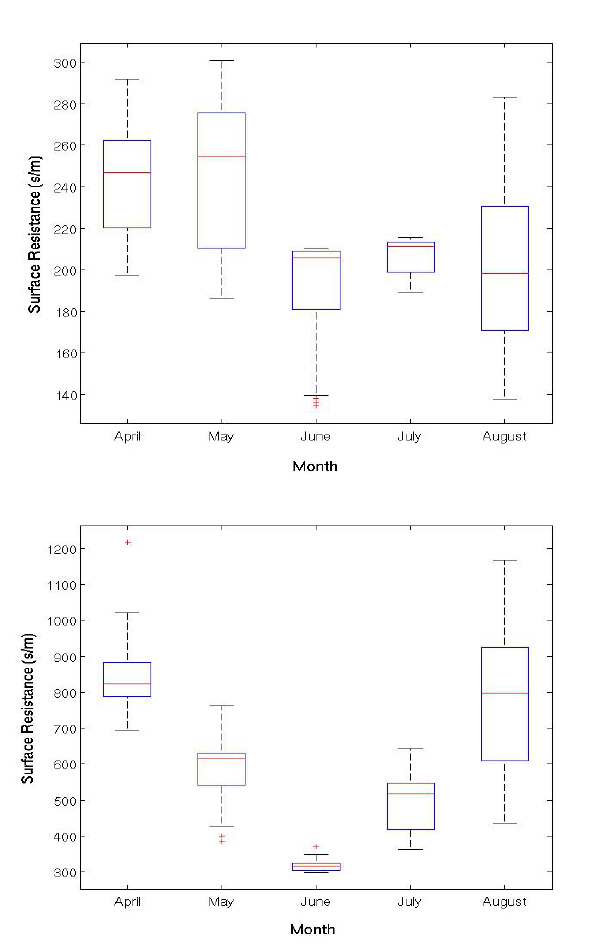
Figure 5: Box plots showing the temporal changes over the spring and summer months of 2011 (upper) and 2012 (lower). Scales are different in the two panels to show the